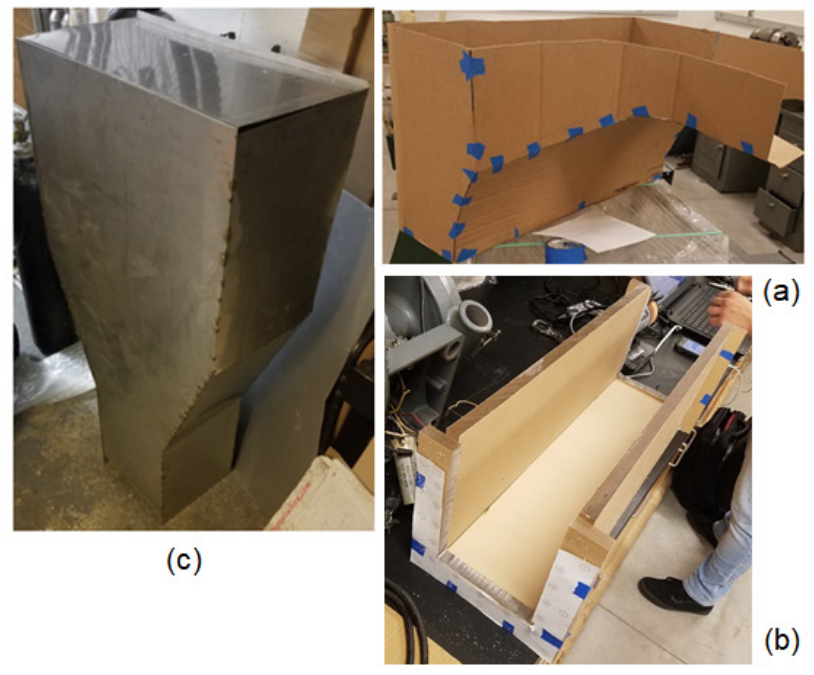
Figure 10. Panel ( a ) shows the cardboard model used in the making of the diffusion channel. Panel ( b ) shows the observation chamber being assembled, and panel ( c ) shows the final product of drainage chamber before being assembled into the main body.